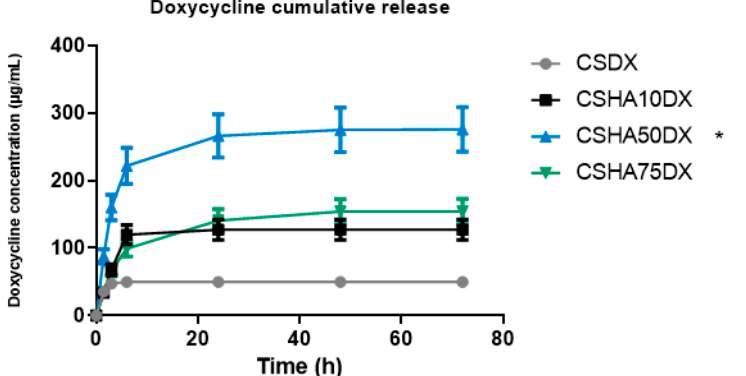
Figure 5. Cumulative amount of doxycycline (DX) released, and percentage of DX released as a function of time for samples 1% chitosan (CS) with different amounts of hydroxyapatite (HA) from 0 to 75%. (* p < 0.05).